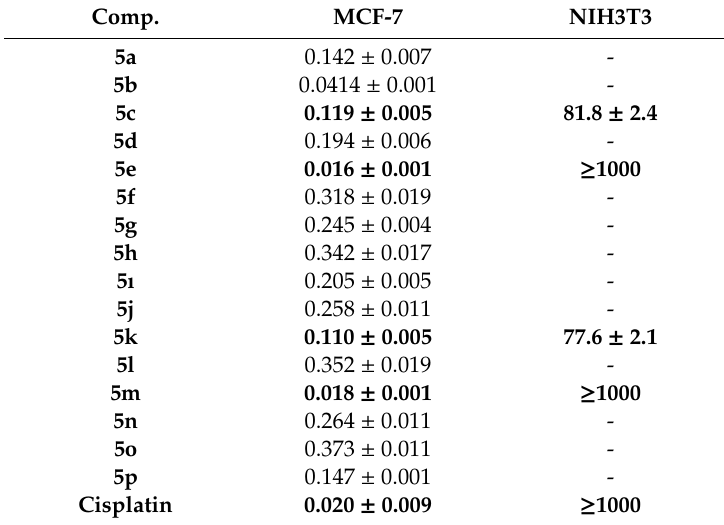
Table 2. IC 50 ( µ M) values of compounds ( 5a – 5p ) ( n = 4). Comp.